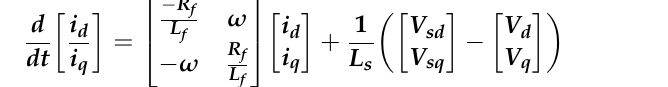
ω denotes the angular frequency while V sd , V sq and V d , V q are the grid and D.G. volt-  denotes the angular frequency while  age in dq reference frame respectively. Further Park’s Transformation can be expressed voltage in dq reference frame respectively. Further Park’s Transformation can be ex- pressed as